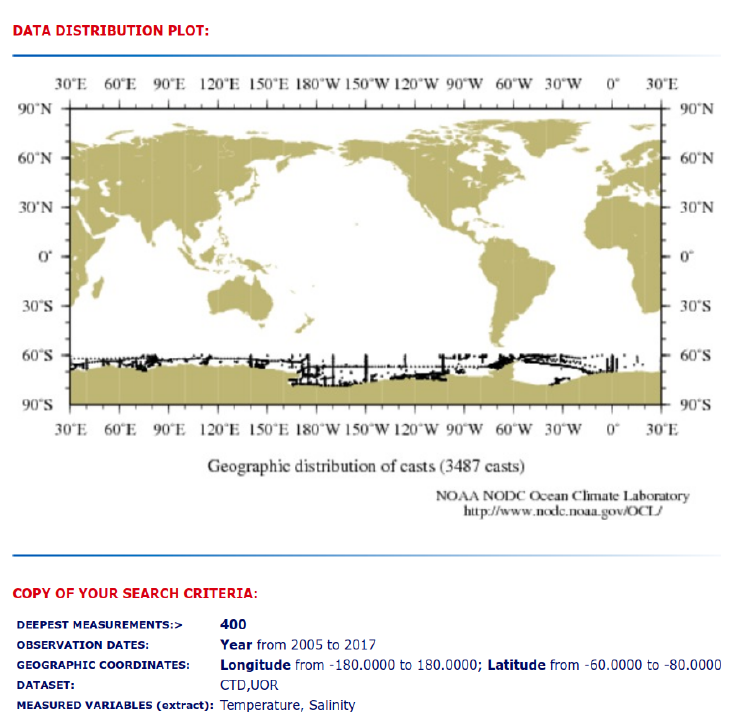
Figure D1. Sampling distribution underlying WOA18 data. Only CTD casts that reached a depth below 400m and measured both temperature and salinity are shown. The distribution clearly shows a high sampling density along summer ship tracks (e.g. along longitudes 170 ◦ , 150 ◦ , 102 ◦ W, 40 ◦ , 60 ◦ , 70 ◦ , and 175 ◦ E) and on the Amundsen Sea continental shelf. The figure has been produced using the World